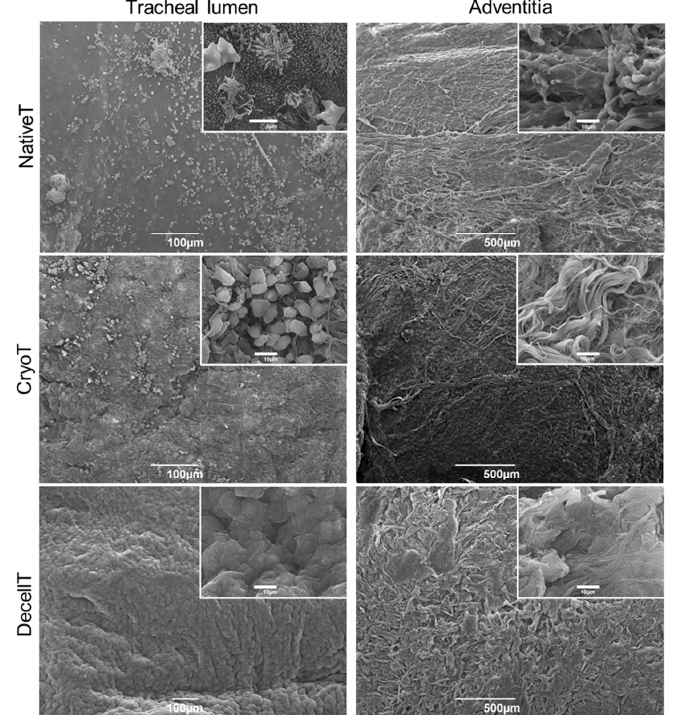
Figure 9. Representative photomicrographs showing ultrastructural appearance of both tracheal lumen and adventitia for native trachea (NativeT), cryopreserved trachea (CryoT) and decellularized trachea (DecellT). Scale bars: 100 µm (tracheal lumen); 500 µm (adventitia); 5 µm (NativeT tracheal lumen, insert); 10 µm (all other inserts).